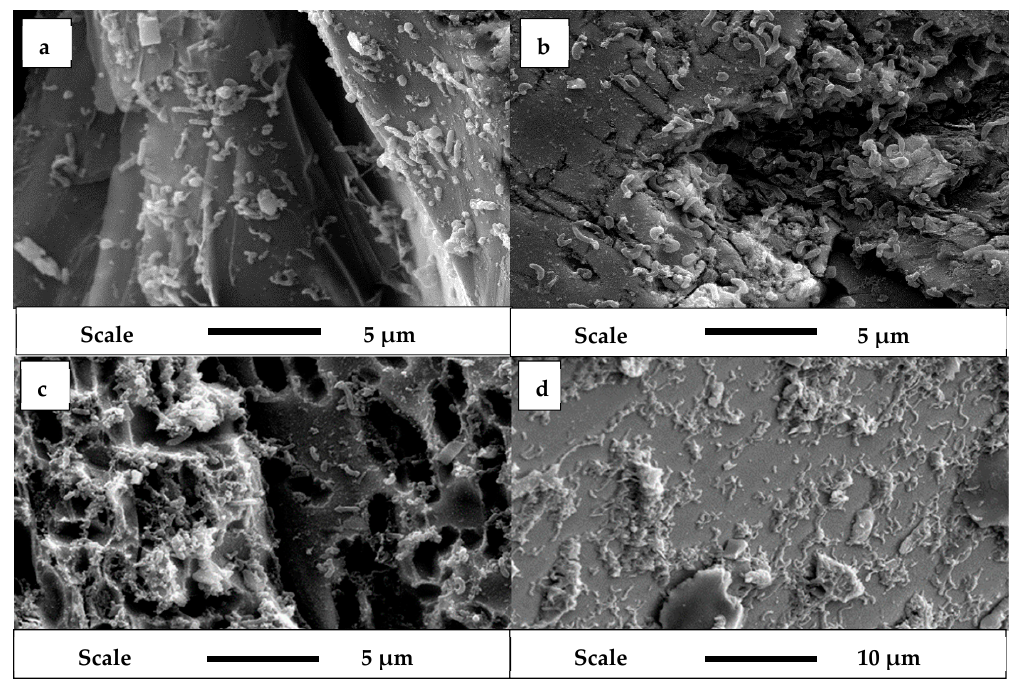
Figure 2. SEM image of Py mineral surface exposed to L.f at ( a ) 2 h, ( b ) 24 h, ( c ) 48 h, and ( d ) 72 h at a magnification of 1000× ( a – c ) and 6500× ( d ).